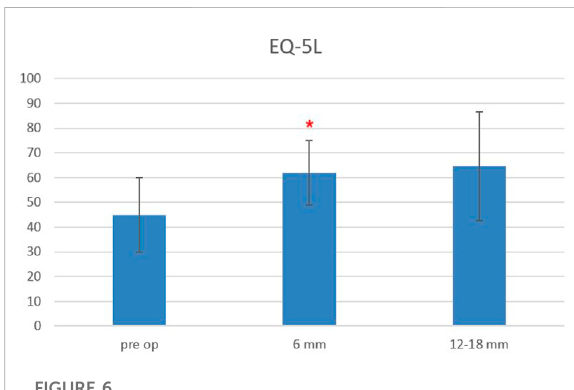
FIGURE 4 Plot of visual analog scale (VAS) scores evaluated pre- operatively, at 6- and 12 – 18-month follow-ups. The red asterisk depicts a signi fi cant difference between post-operative and pre- operative values.